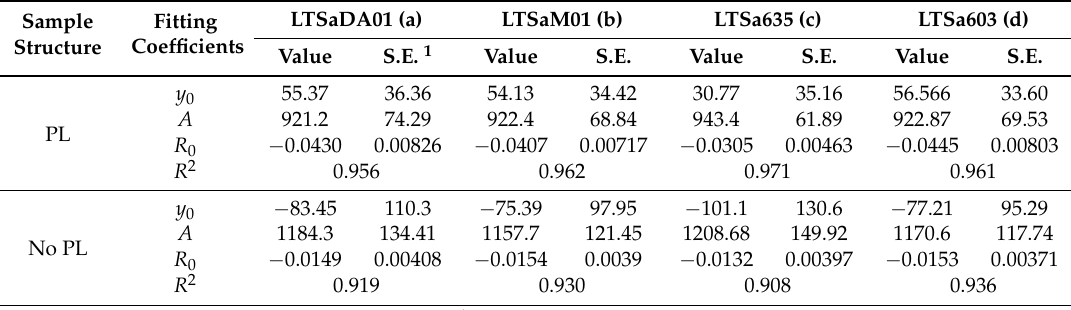
Table 2. Coefficients of exponential dependencies used in the approximations of CFU versus time for four types of S. aureus bacteria strains.